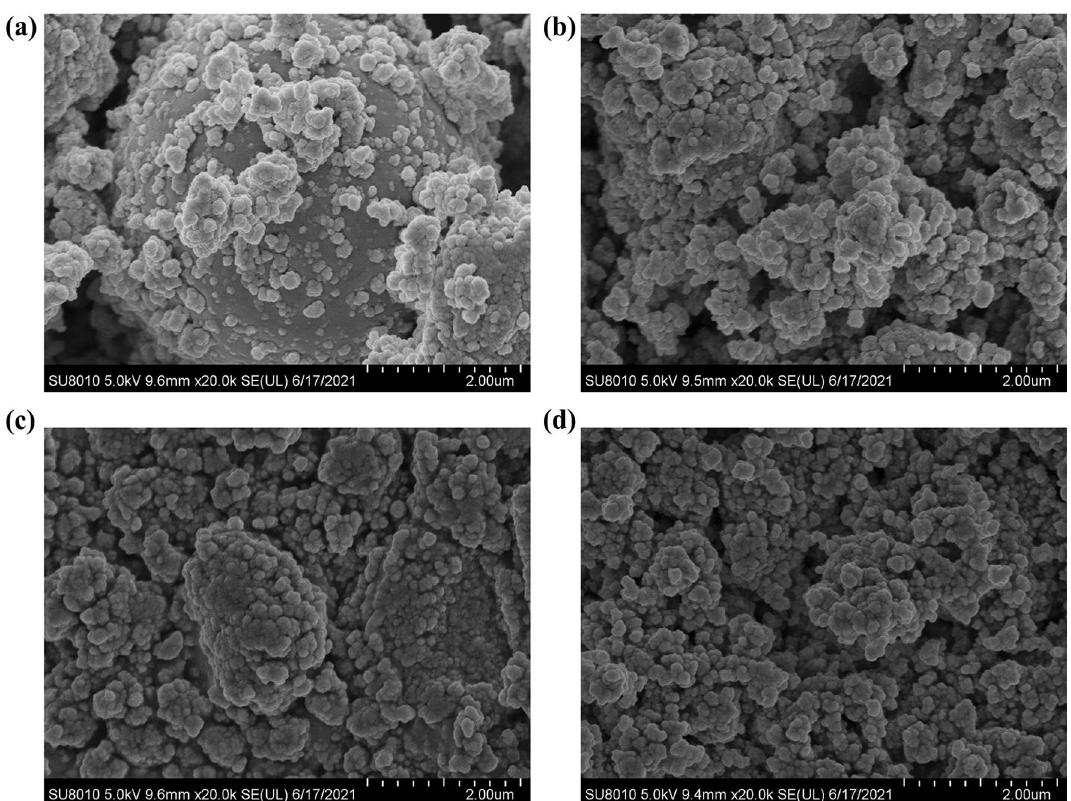
Figure 7. SEM micrographs of the synthesized materials: ( a ) BiFeO 3 , ( b ) Gd-BiFeO 3 , ( c ) Nd-BiFeO 3 , and ( d )